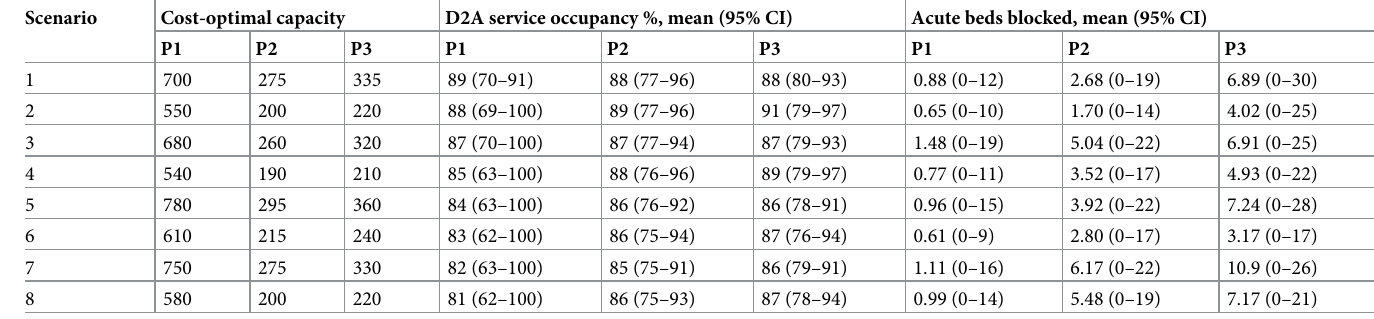
Table 2. Estimated cost-optimal capacities (daily maximum number of visits for P1; beds for P2 and P3) and corresponding summarised results for mean (95% CI) D2A service occupancy (expressed as a percentage of total capacity) and mean (95% CI) number of acute beds blocked. Scenario Cost-optimal